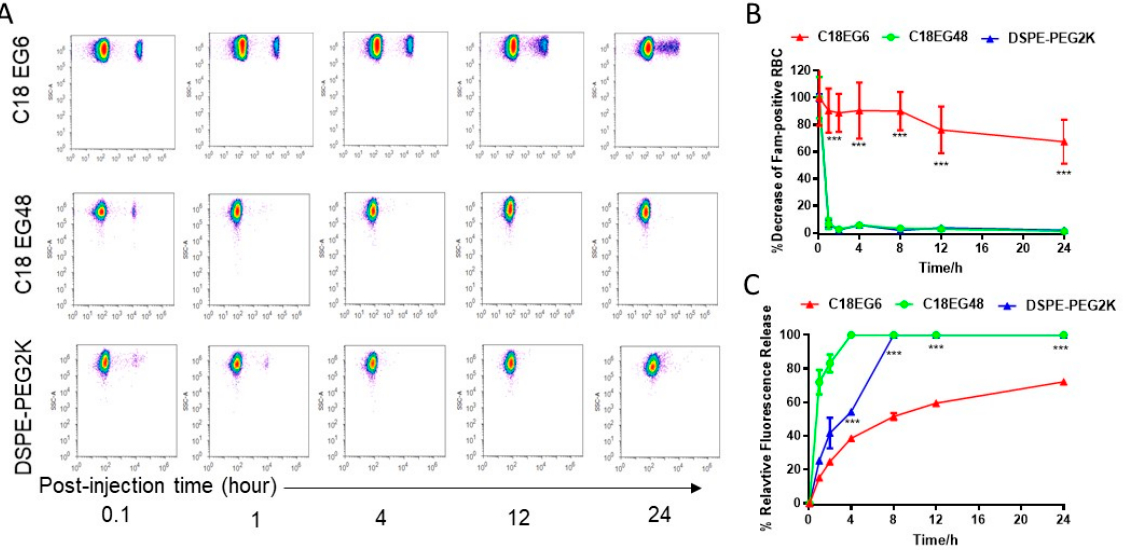
Figure 3. In vivo release kinetics of C18EG6, C18EG48, and DSPE-PEG2K loaded RBCs. ( A ) Representative flow cytometry dot plots. ( B , C ) The relative frequencies of Fam-positive RBCs ( B ) and mean fluorescence intensities ( C ) at different time points after injection. Each time point was assayed with three replicates. Error bars represent the SEM. *, p < 0.05; **, p < 0.01; ***, p < 0.001; ****, p < 0.0001; ns, not significant. Statistical analyses were made by comparing C18EG6 and C18EG48 groups.